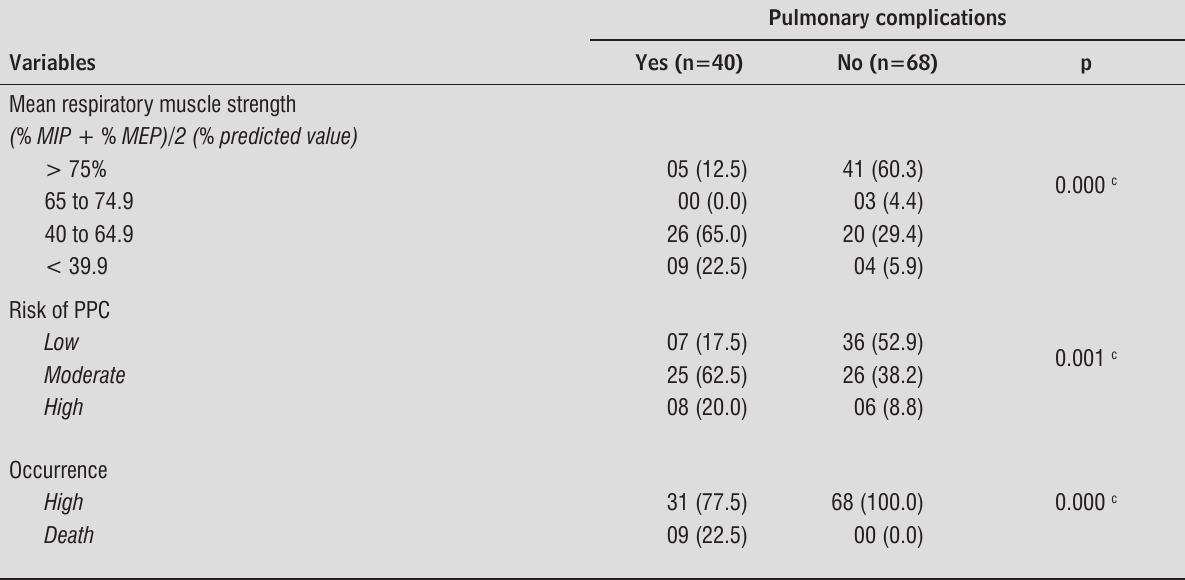
Table 5 - Distribution of PPC with respect to the items evaluated on the scale